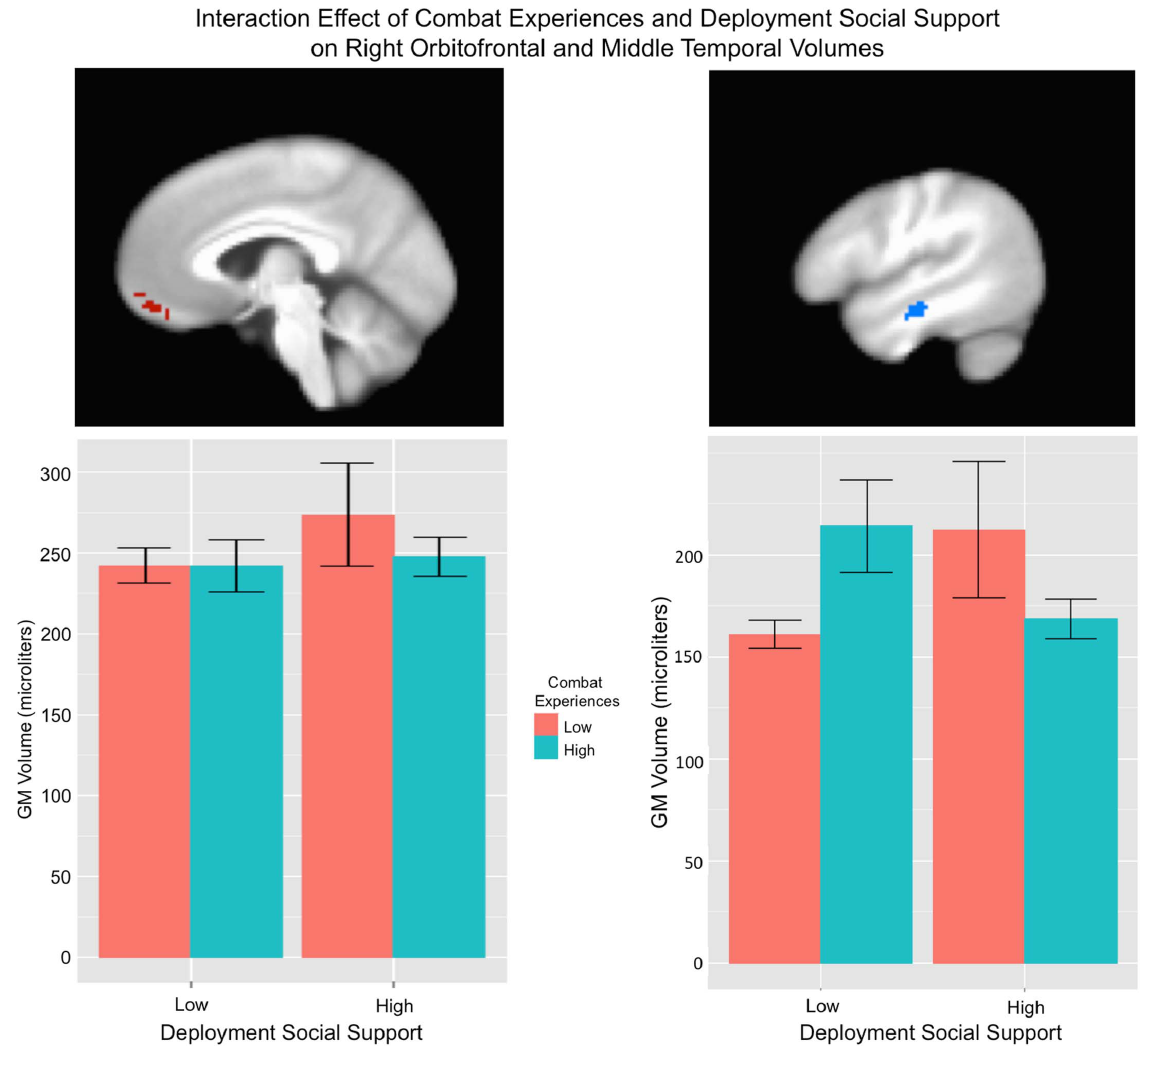
Figure 2. Interaction between combat experiences and deployment social support regarding gray matter volume. Deployment experiences were measured using the Deployment Risk and Resilience Inventory (DRRI). There was a significant interaction effect on gray matter volume between the subscales corresponding to level of combat experiences and deployment social support within the right orbitofrontal gyrus (BA 11; shown at x=4) and right middle temporal gyrus (BA 22; shown at x=48). For the right orbitofrontal gyrus, high social support combined with low combat experiences related to greater volume. For the middle temporal gyrus, high social support in combination with low combat experiences, or low social support in combination with high combat experiences related to greater volume. Shaded areas represent 95% confidence intervals. See Table 2 for statistical results.